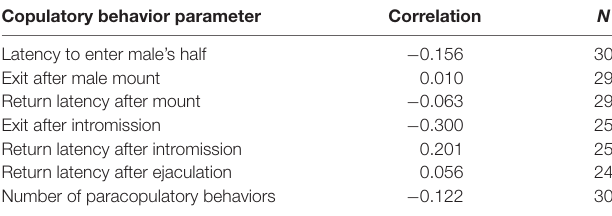
TABLE 4 | Pearson correlations between sexual approach behavior and copulatory behavior in ovariectomized female rats given EB, 25 µ g and P, 1 mg, 48 and 4 h before being subjected to a test for sexual approach behavior immediately followed by a test for copulatory behavior in the divided